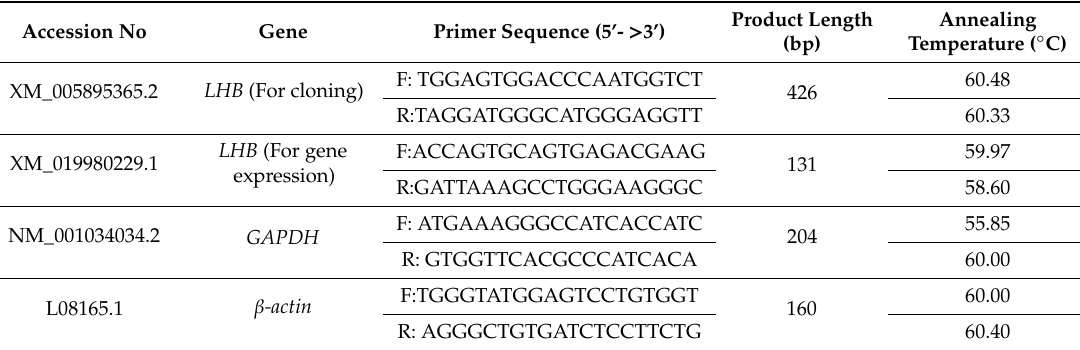
Table 1. Primers used for qPCR and